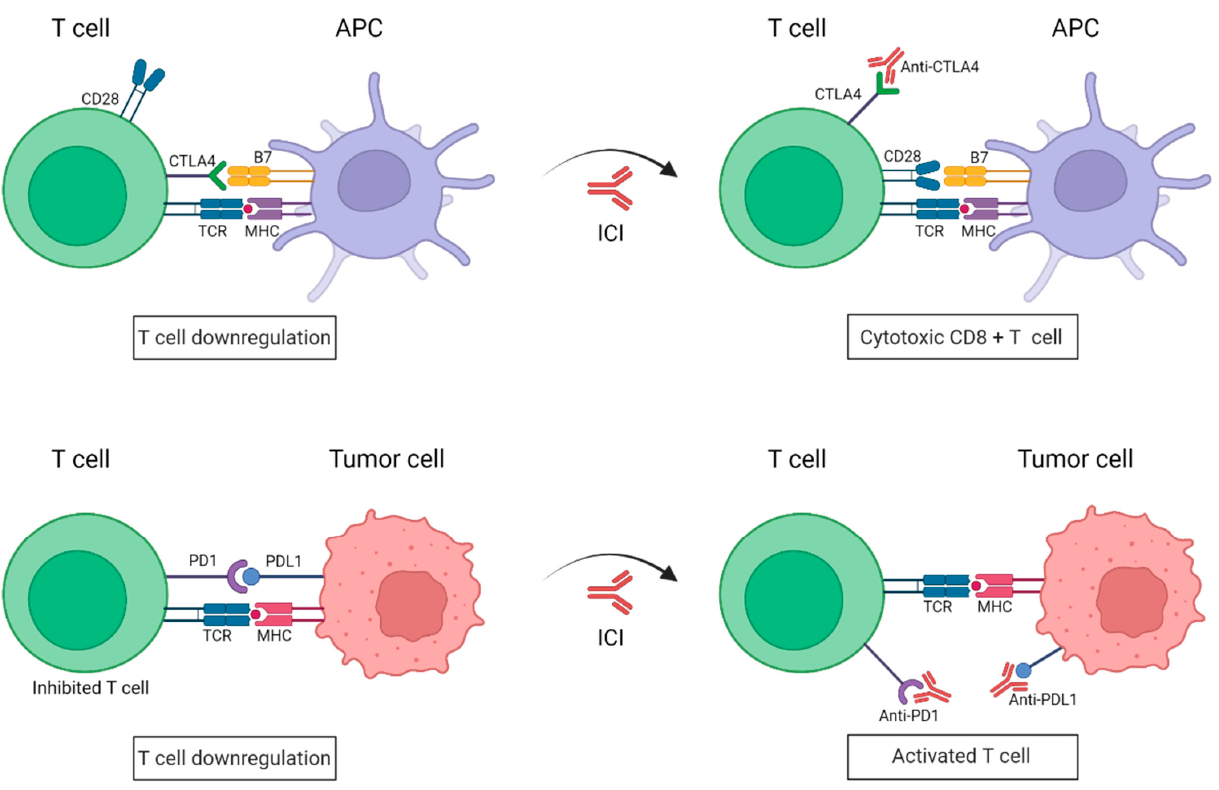
Figure 1. Schematic representation of immune checkpoint blockade by antibodies anti-PD1 and anti-CTLA4. Under normal conditions, the binding of PD1 expressed on activated T cells to its ligand PDL1 on tumor cells causes T-cell exhaustion. CTLA4 and CD28 are found in T cells and they compete with each other to bind their ligand B7 present on APCs. CTLA4 has a higher affinity to B7 than CD28 and transmits an inhibitory signal to T cells, whereas CD28 transmits a T-cell stimulatory signal. In the presence of ICIs, anti-PD1/PDL1 antibodies impede the union of PD1 to its ligand PDL1, resulting in a killed tumor cell; whereas anti-CTL4 antibodies work by blocking the inhibitory B7-CTLA-4 signaling, allowing T cells to be active. APC: Antigen-presenting cell; TCR: T-cell receptor; MHC: major histocompatibility complex; PD1: programmed death-1; PDL1: programmed death-ligand 1; CTLA4: cytotoxic T lymphocyte antigen. (Created with BioRender; www.biorender.com, access date: 20 October 2022).